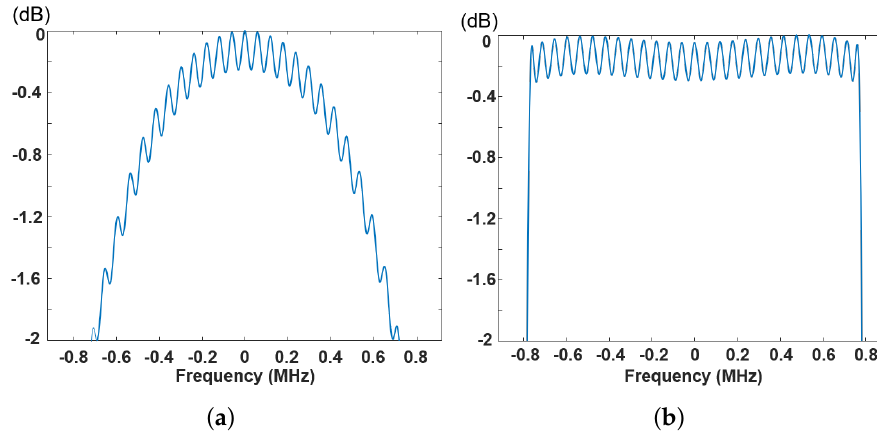
Figure 5. Frequency response according to decimation ratio. ( a ) R a = 40. ( b ) R b =